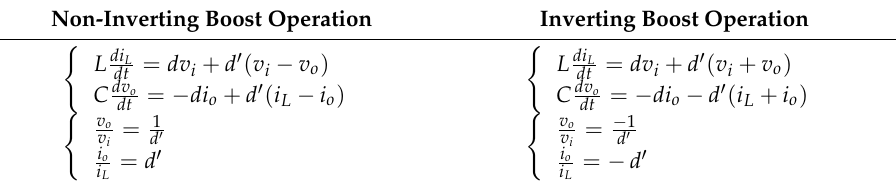
Table 2. PWM switching average modelling and corresponding transfer ratio for boost operation. Non-Inverting Boost